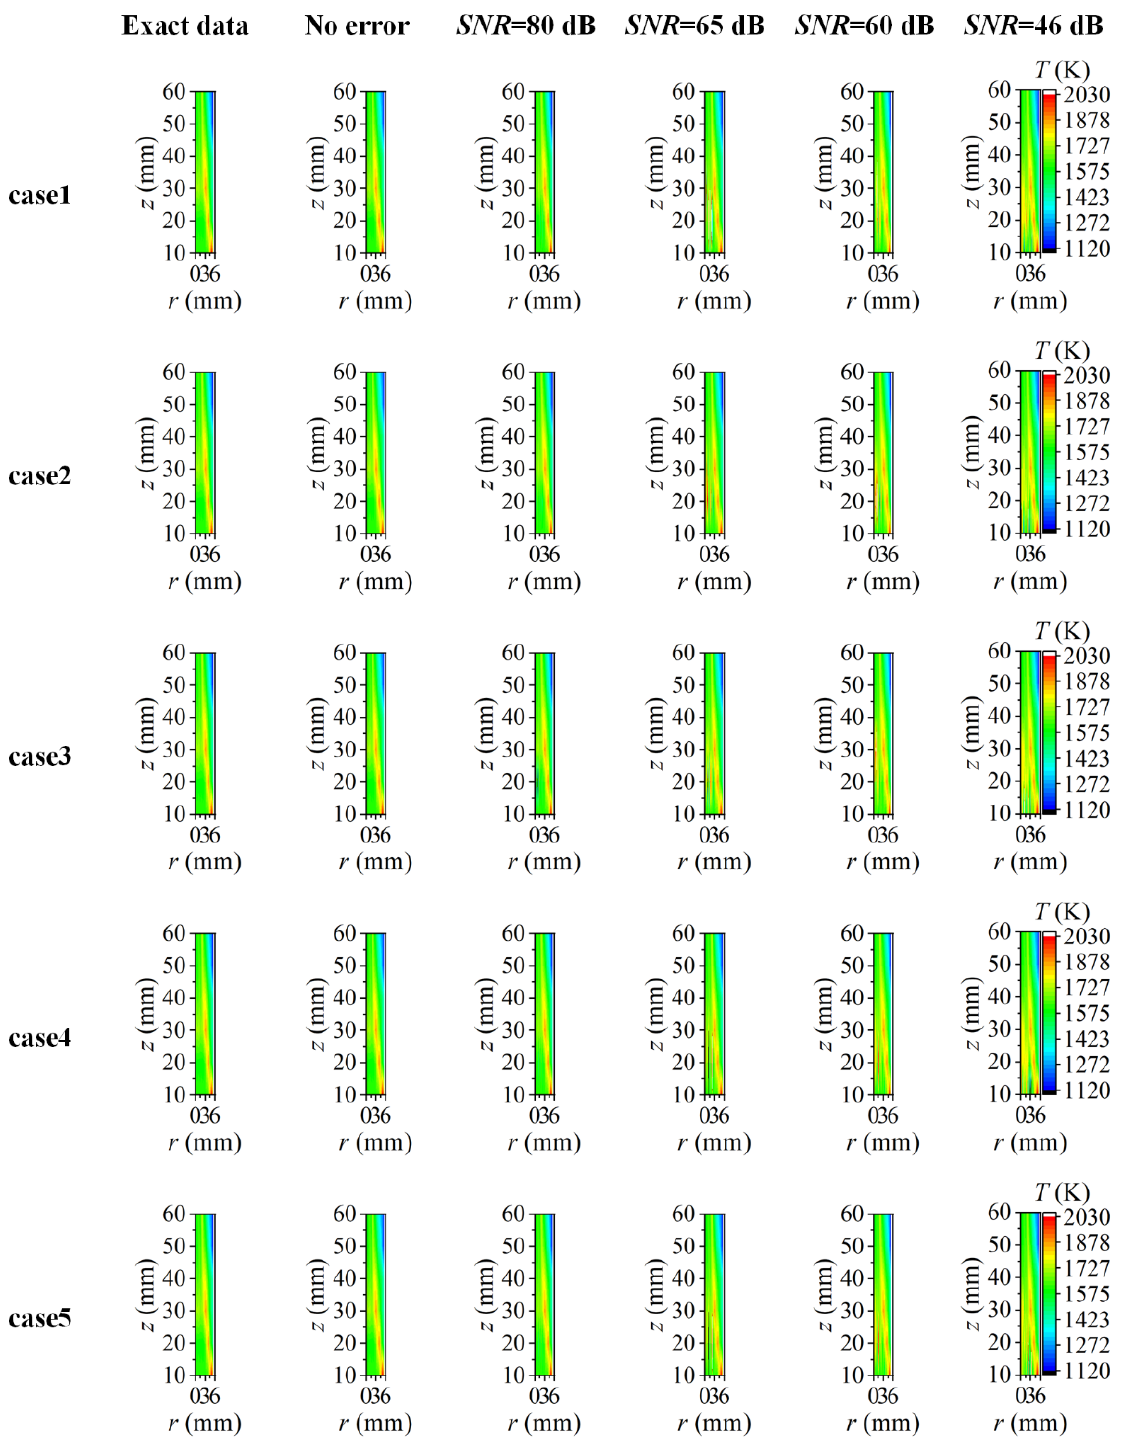
Figure 20. The reconstructed 2D flame temperature under different SNR considering different reconstruction boundaries.